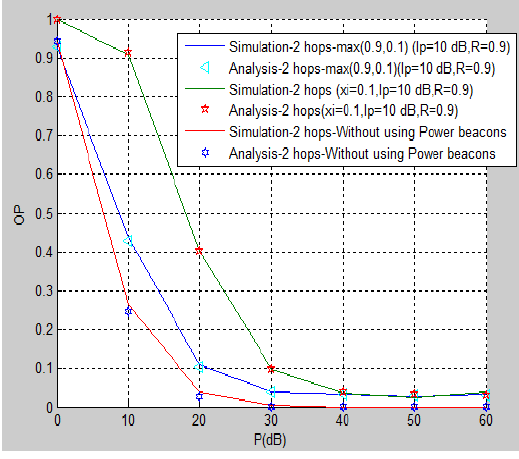
Fig. 2. OP versus P (dB): K=2, ( x PU , y PU ) =(2, 2),